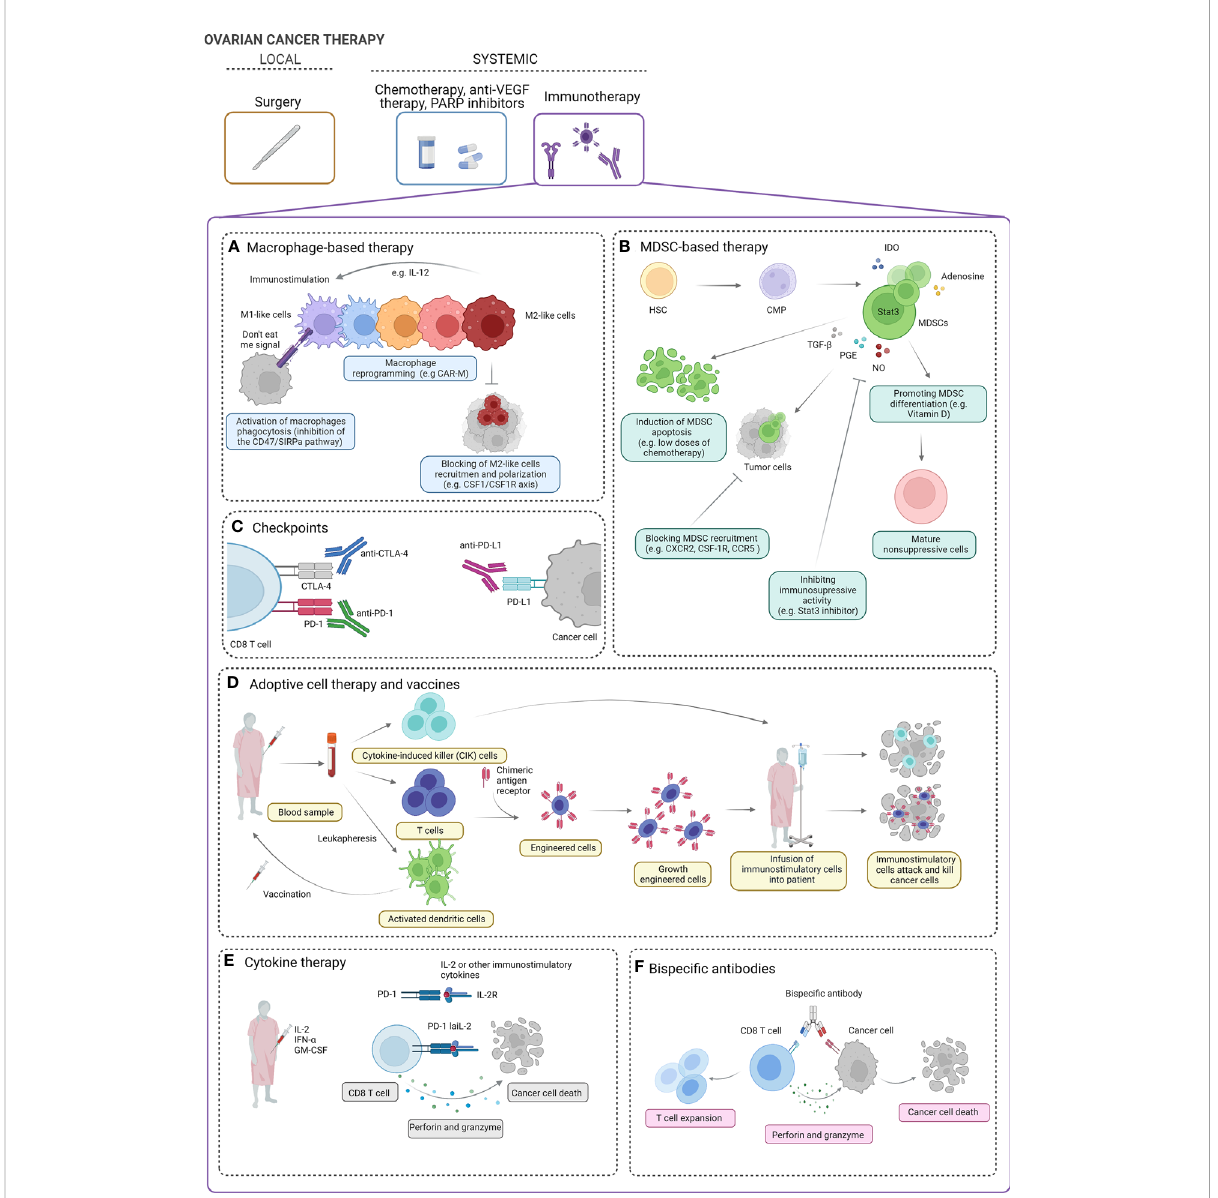
FIGURE 2 Ovarian cancer therapy. The standard treatment for ovarian cancer (OC) includes local intervention (debulking surgery) followed by systemic treatment [chemotherapy, anti-vascular endothelial growth factor (VEGF) therapy, PARP inhibitors]. Several strategies of systemic immunotherapy can be of clinical bene fi t in OC patients. Macrophage-based strategies can include activation of macrophage phagocytosis, macrophage reprogramming into immunostimulatory M1-like phenotype, and blocking of M2-like cell recruitment (A) ). Myeloid-derived suppressor cell (MDSC)-based strategies include induction of MDSC apoptosis, blocking MDSC recruitment, inhibiting the immunosuppressive activity of MDSCs, and promoting the differentiation of MDSCs into mature non-suppressive cells (B) . Blocking of immunoinhibitory checkpoints (e.g., PD-1, PD-L1, CTLA-4, and others) can boost the immune response and promote ovarian tumor cell killing (C) . Cytokine-induced killer (CIK) cells, engineered immune cells (e.g., T cells), and dendritic cell vaccines can be used to boost the antitumor immune response cell activity and enhance cancer cell killing (D) . In clinical studies, using IL-2, IFN- a , and GM-CSF has been proposed in OC treatment. In preclinical studies, modi fi ed low-af fi nity IL-2 fusion protein in combination with anti-PD-1 (PD-1-laIL-2) decreases af fi nity for Tregs and increases avidity to CD8 TILs, which promotes better tumor control and less toxicity than single or combination treatments (E) . Bispeci fi c antibodies have af fi nity for both the tumor-associated antigen and the CD8 effector T cells. In the presence of perforin and granzyme, they effectively target T lymphocytes to elicit antitumor effects (F) . IL, Interleukin; M1 and M2, macrophages; CAR-M, chimeric antigen receptor macrophage; CSF-1: macrophage- colony stimulating factor; CSF-1R, macrophage colony stimulating factor signaling through its receptor, SIRPA, signal regulatory protein alpha; HSC, hematopoietic stem cells; CMP, common myeloid progenitor; IDO, indoleamine 2,3-dioxygenase; STAT3, signal transducer and activator of transcription 3; TGF-b, transforming growth factor- beta; PGE, prostaglandin E; NO, nitric oxide; CXCR2, chemokine C-X-C motif receptor 2; CCR5, C-C motif chemokine receptor 5; CTLA-4, cytotoxic T-lymphocyte associated protein 4; PD-1, programmed cell death protein 1; PDL-1, programmed cell death ligand 1; INF-alfa, interferon alpha; GM-CSM, granulocyte macrophage colony-stimulating